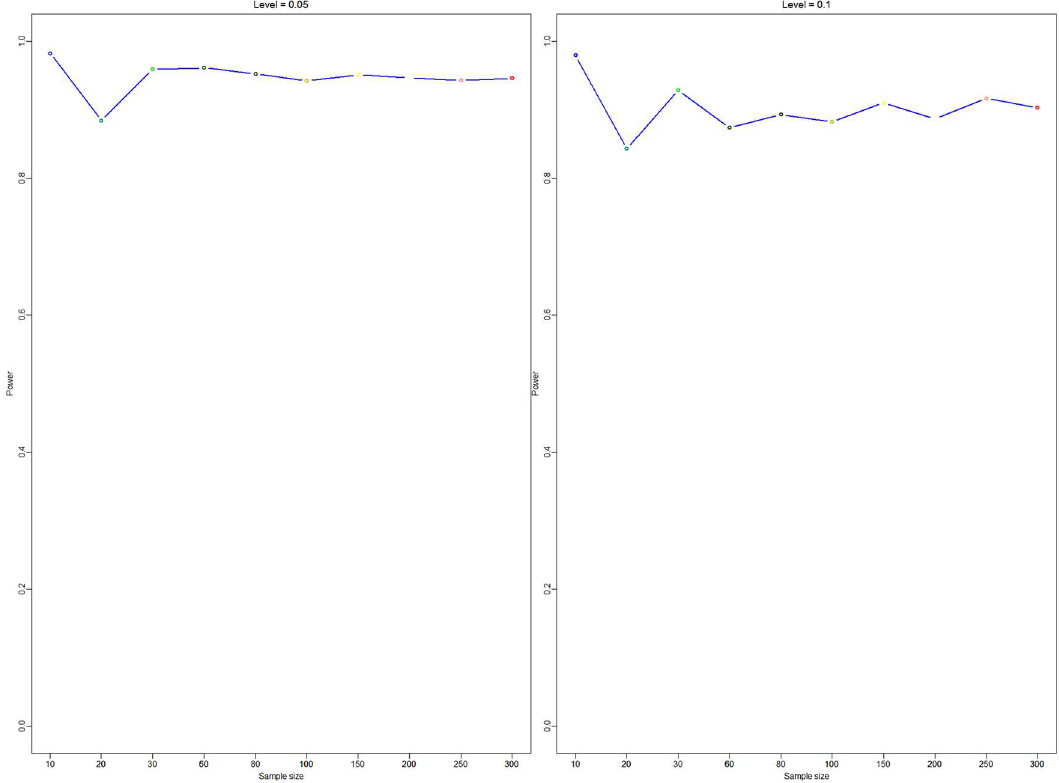
Fig 2. Test H 0 : Ψ 1, A ( t ) = 0.889 vs H 1 : Ψ 1, A ( t ) 6¼ 0.889. The x-coordinate is the sample size, and the y-coordinate is power. The level of significance in the left panel is 0.05, and the level of significance in the right panel is 0.1.